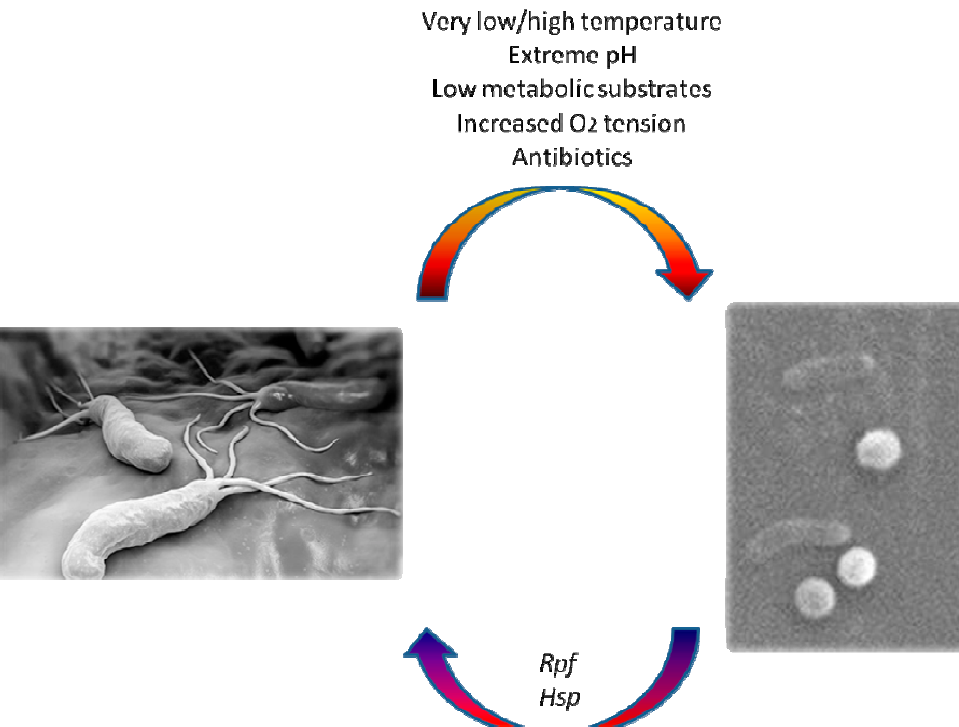
Figure 1. Transition from spiral-shaped viable form of H. pylori to viable but non culturable (VBNC) coccoid forms (scanning electron microscope) and factors affecting this process.